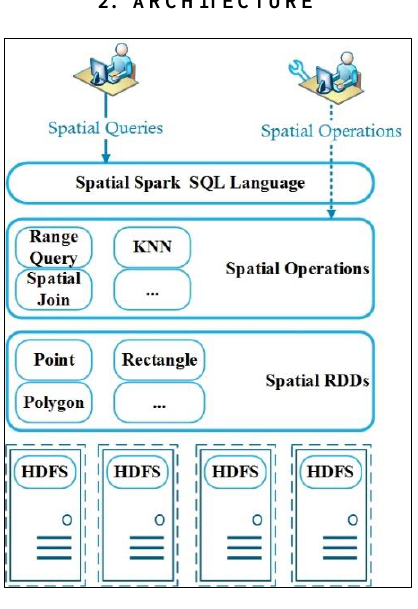
Figure 1. System